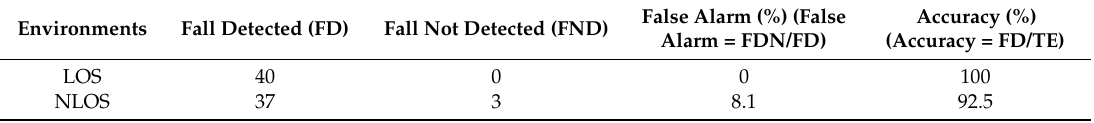
Table 3. Fall detection accuracy of the proposed sensor-based